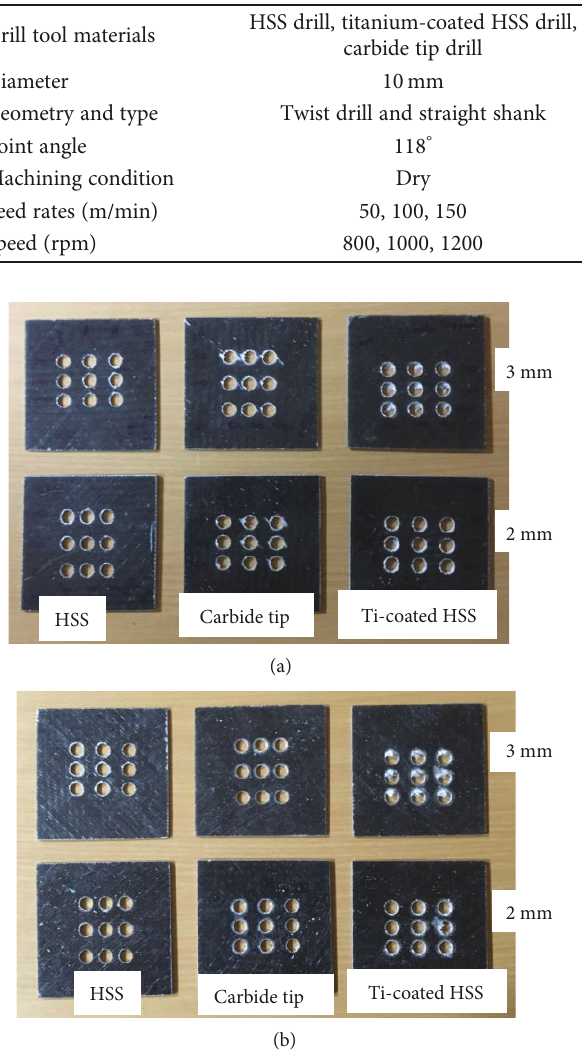
Figure 4: (a) Drilled samples at the entry side. (b) Drilled samples at the exit side.